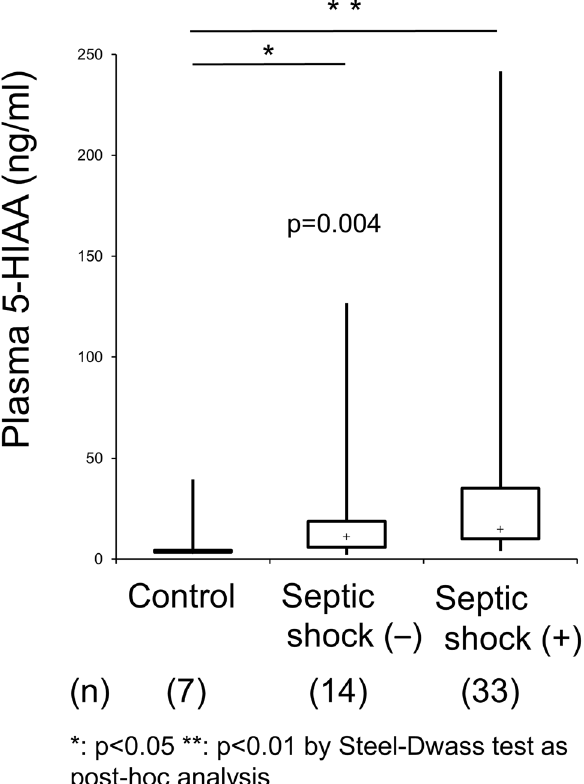
Figure 1. Plasma 5-HIAA levels in patients with septic infection. Plasma 5-HIAA levels among healthy controls, sepsis patients without septic shock, and sepsis patients with septic shock were determined by the Kruskal–Wallis test and Steel–Dwass test for post-hoc analysis. *p < 0.05, **p < 0.01 by Steel–Dwass